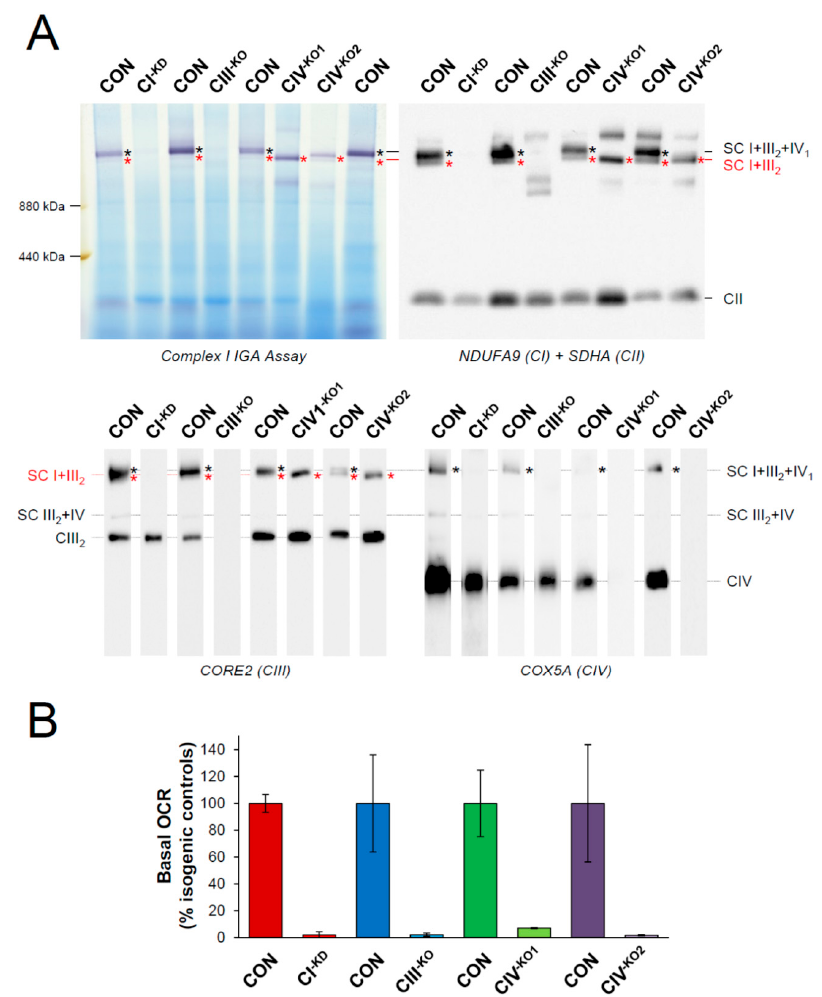
Figure 1. Structural and functional defects of the respiratory chain in mutant transmitochondrial cybrids. ( A ) Mitochondria were isolated from isogenic controls (CON) and mutant cybrids harboring homoplasmic mutations in the mitochondrial MT-ND2 (CI − KD ), MT-CYB (CIII − KO ), MT-CO1 (CIV1 − KO ), and MT-CO2 (CIV2 − KO ) genes. Digitonized mitochondria (digitonin-to-protein ratio of 4:1) were analyzed by BN-PAGE, and supercomplexes were visualized by complex I in-gel activity (IGA) assay and Western blot with the indicated antibodies that recognize subunits from MRC complexes I-IV. The relative position of the molecular weight marker is indicated on the left of the upper panels. The identity of the respiratory chain supercomplexes (SCs) is I + III 2 + IV 1 , SC containing complexes I, III 2 and IV; I + III 2 , SC containing complexes I and III 2 ; III 2 + IV, SC containing complexes III 2 and IV; III 2 , CIII dimer. ( B ) Mitochondrial basal oxygen consumption rates (OCR) were measured in control (CON) and mutant cybrids respiring in 4.5 g / L glucose-containing medium. Three technical measurements per sample were performed in two independent experiments in the isogenic controls (CON) and the CI − KD , CIII − KO , and CIV2 − KO cell lines, and once in the CIV1 − KO cybrids. Data are expressed as the mean ± SD of the percentages of the isogenic control values. OCR values were calculated in pmol O 2 .min − 1 . µ g protein − 1 in all